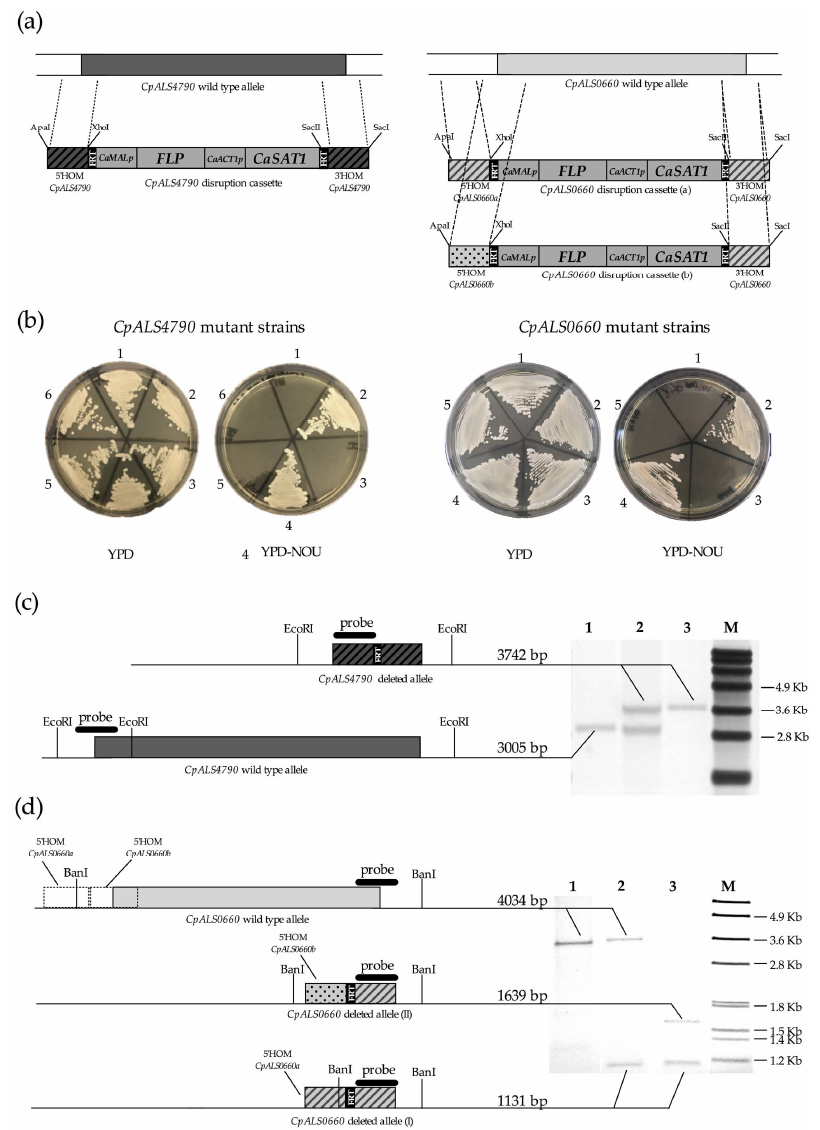
Figure 1. Gene disruption strategy and southern blot analysis of the mutant panel. ( a ) Left panel: CpALS4790 disruption cassette harbouring the two homology regions (5 (cid:48) HOMCpALS4790 and 3 (cid:48) HOMCpALS4790) required for the correct integration in the target locus. Right panel: CpALS0660 disruption cassette harbouring the homology regions (5 (cid:48) HOMCpALS0660, 5 (cid:48) HOMCpALS0660b and 3 (cid:48) HOMCpALS0660) required for the correct integration in the target locus. The following abbreviations are used in the description of disruption cassettes: CaMAL2p : C. albicans maltose-inducible promoter; CaFLP : C. albicans -adapted FLP gene encoding the site-specific recombinase FLP ; CaACT1p : C. albicans actin promoter; CaSAT1 : C. albicans -adapted Nourseothricin resistance marker; FRT: (FLP-recognition target) minimal recombination target sites of the FLP recombinase. ( b ) Left panel: CpALS4790 mutant collection plated on YPD and YPD-Nou agar plates and grown for 48 h at 30 ◦ C. 1: ATCC 22019; 2: CpALS4790HC; 3: CpALS4790H; 4: CpALS4790KOC; 5: CpALS4790KO; 6: ATCC 22019. Right panel: CpALS0660 mutant collection plated on YPD and YPD-Nou agar plates and grown for 48 h at 30 ◦ C. 1: ATCC 22019; 2: CpALS0660HC; 3: CpALS0660H; 4: CpALS0660KOC; 5: CpALS0660KO. ( c ) Schematic representation of the Southern blot strategy used to check the genotype of the CpALS4790 mutant collection. 1: ATCC 22019; 2: CpALS7490H; 3: CpALS4790KO; M: Roche Dig Labelled Marker VII. ( d ) Schematic representation of the Southern blot strategy used to check the genotype of the CpALS0660 mutant collection. 1: ATCC 22019; 2: CpALS0660H; 3: CpALS0660KO; M: Roche Dig Labelled Marker